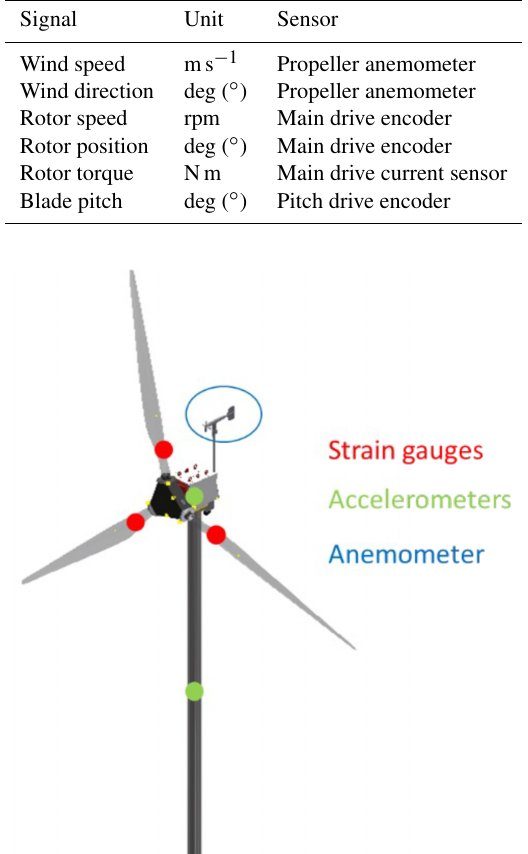
set of sensors is devoted to load and vibration monitoring. Tower base strain gauges are arranged in two half-bridge configurations, to measure flexional stresses on two perpen- dicular axes, and a full bridge for torsional stress sensing. Blade strain gauges are arranged so as to measure flapwise and edgewise bending stresses and torsional stresses on one of the blades, the other two being provided only with flap- wise bending stress measurement instruments. Acceleromet- ric measurement is accomplished by means of two triaxial accelerometers, one placed in the nacelle and the other at mid-tower (Fig. 4). Data are acquired by an NI PXIe at a 50 Hz sampling rate. Files containing time histories are sent to a laboratory on